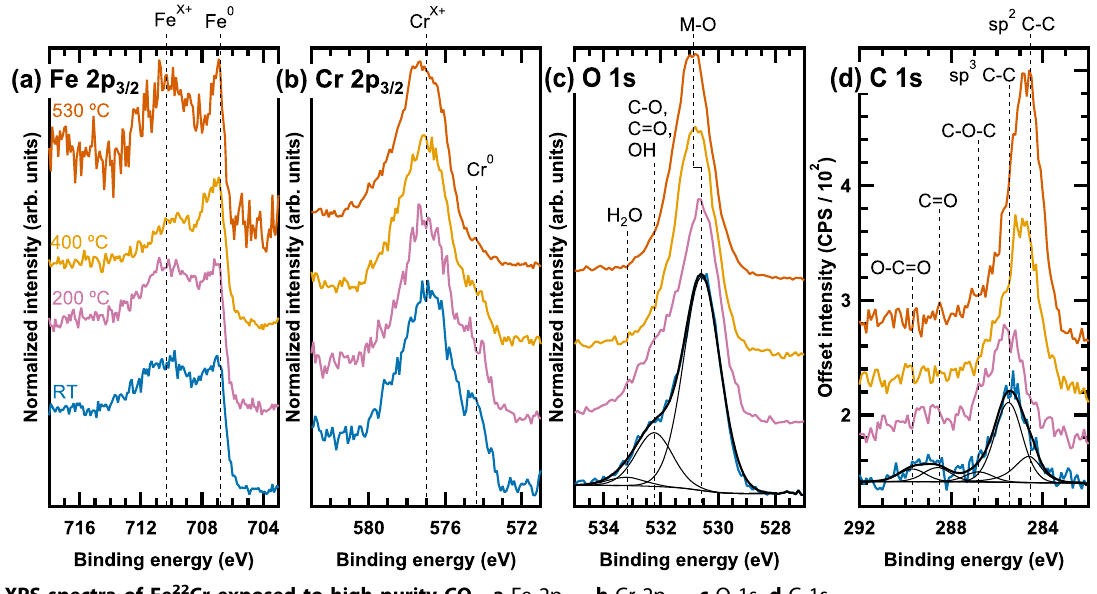
Fig. 1 AP-XPS spectra of Fe 22 Cr exposed to high purity CO 2 . a Fe 2p 3/2 . b Cr 2p 3/2 . c O 1s. d C